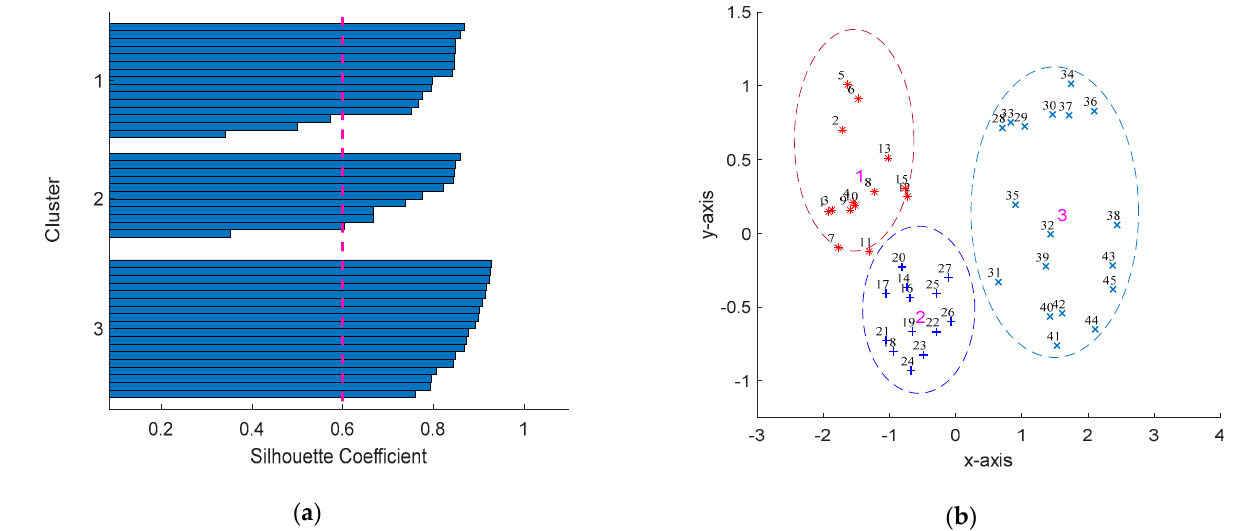
Figure 6. ( a ) Silhouette coefficient values, and ( b ) Visualization of clustered data when number of clustering = 3.